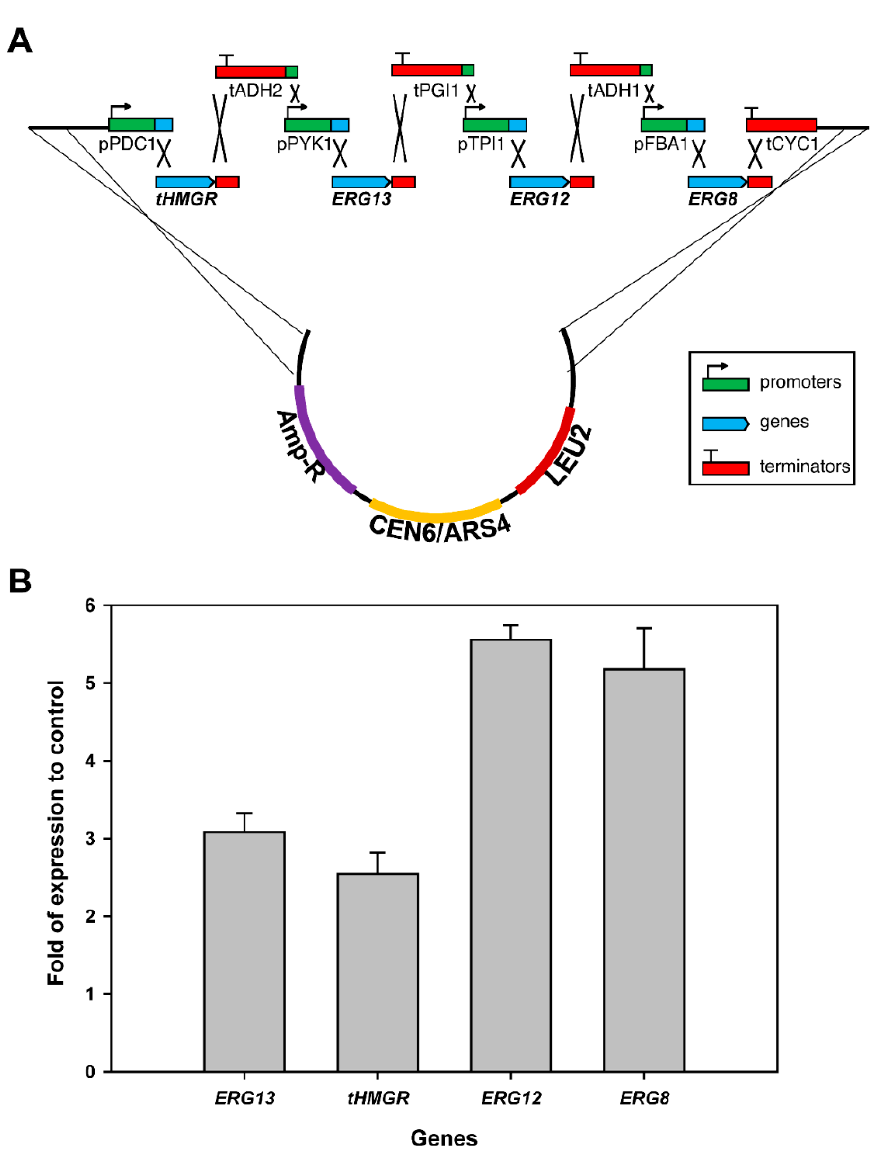
Figure 2. ( A ) A schematic diagram of the in vivo construction of pIPP plasmid encoding four mid- dle genes in the MVA pathway. Abbreviations: p : promoter; t : terminator; PDC: pyruvate decarboxylase; ADH: alcohol dehydrogenase; PYK: pyruvate kinase; PGI: phosphoglucose isomerase; TPI: triose phosphate isomerise; FBA: fructose 1,6-bisphosphate aldolase; CYC: cytochrome c; tHMGR: truncated 3-hydroxy-3-methylglutaryl-CoA reductase. ( B ) The transcript abundance of